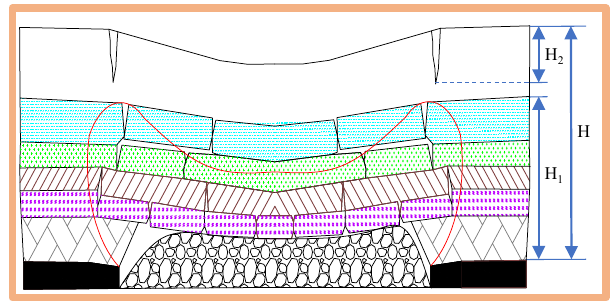
Figure 15. Surface damage assessment